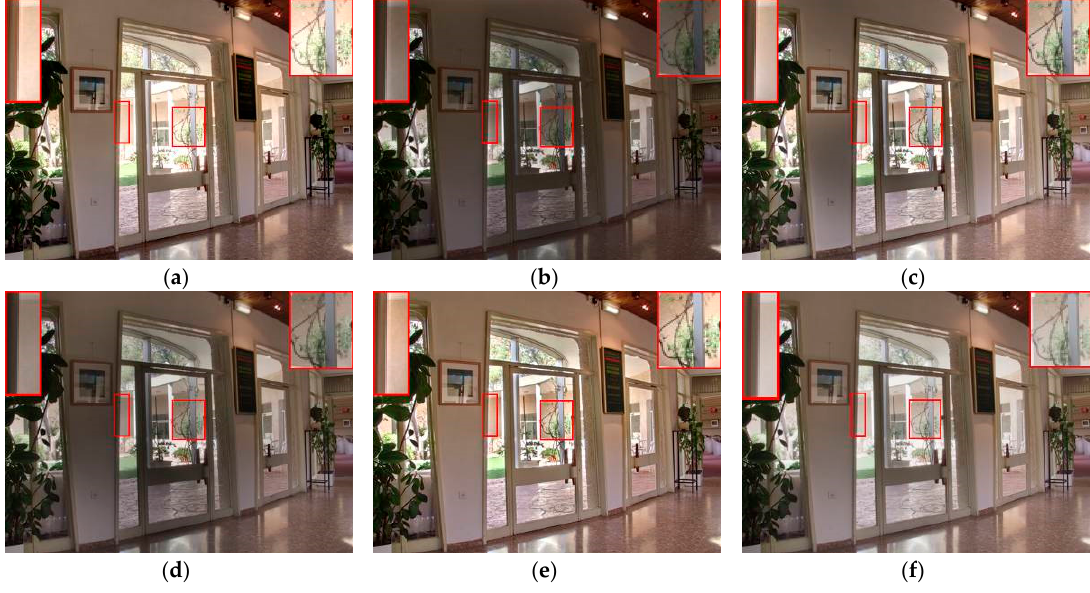
Figure 9. Performance comparison of different methods on the “Belgium House” image sequence. ( a ) Mertens10 [15]; ( b ) Vonikakis11 [16]; ( c ) Li13 [18]; ( d ) Liu15 [12]; ( e ) Ma18 [14]; and ( f ) the proposed method.